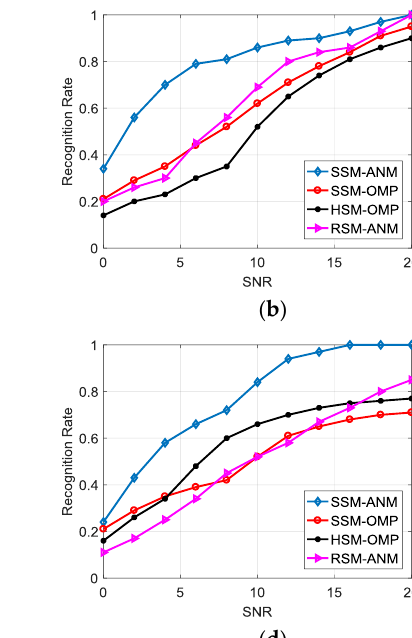
( d ) Figure 9. Recognition performance comparison in different SNRs (CPI = 20). ( a ) Type A; ( b ) Type B; ( c ) Type C; ( d ) Type D.